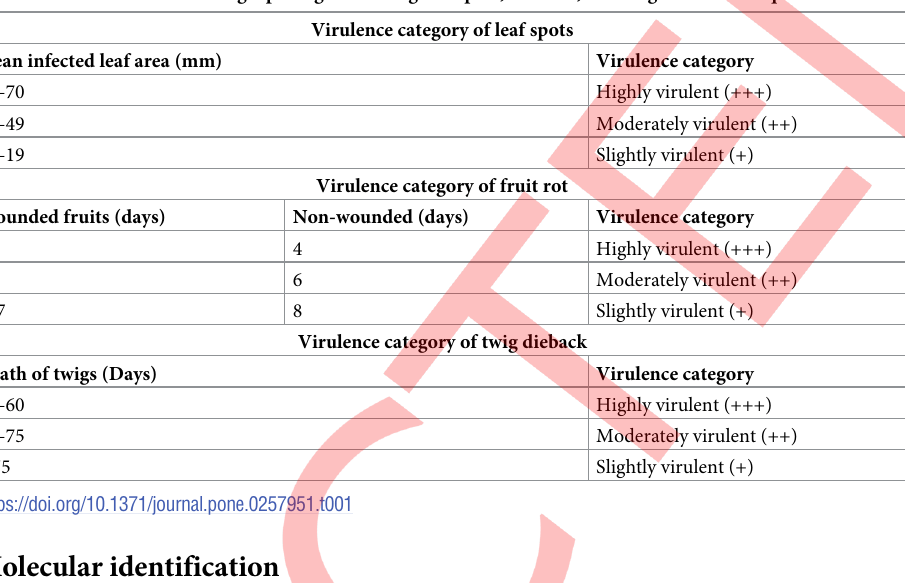
Table 1. Virulence scales of fungal pathogens causing leaf spots, fruit rot, and twig dieback of loquat.